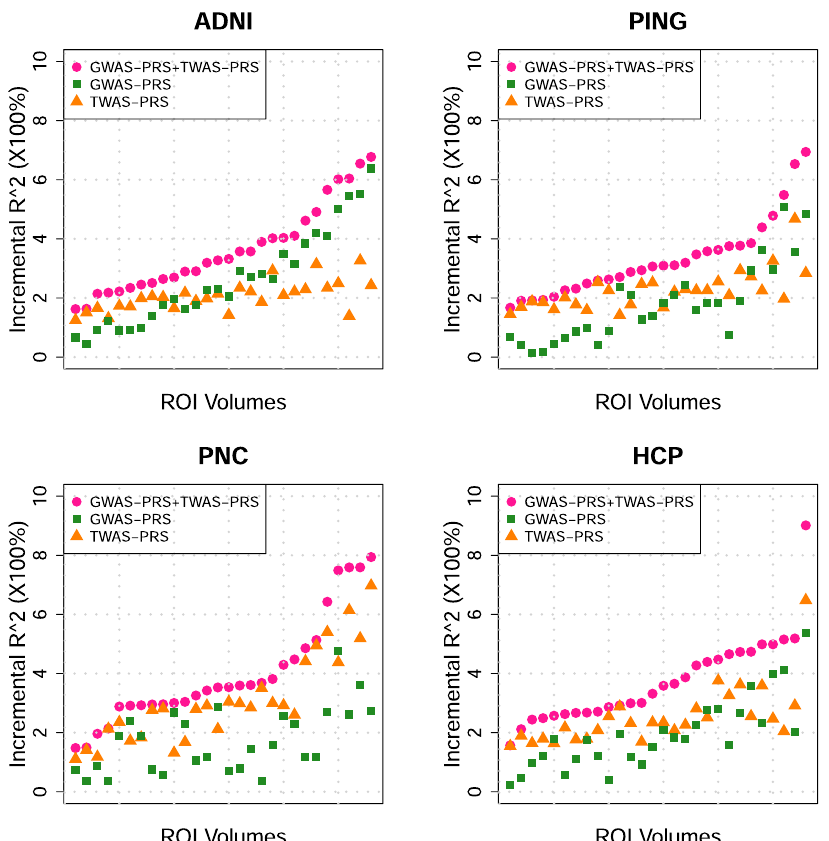
Fig. 5 Prediction accuracy (incremental R 2 ) of gene-based polygenic risk scores constructed by UKB-derived TWAS summary statistics (TWAS PRS), variant-based PRS constructed by UKB-derived GWAS summary statistics (GWAS PRS), and both of them (GWAS PRS + TWAS PRS) on the four independent data sets ( n = 19,629 subjects). The x axis lists 28 ROI volumes whose TWAS PRS are signi fi cant in all the four data sets after the Bonferroni correction and the y axis lists the proportions of phenotypic variation that can be additionally explained by